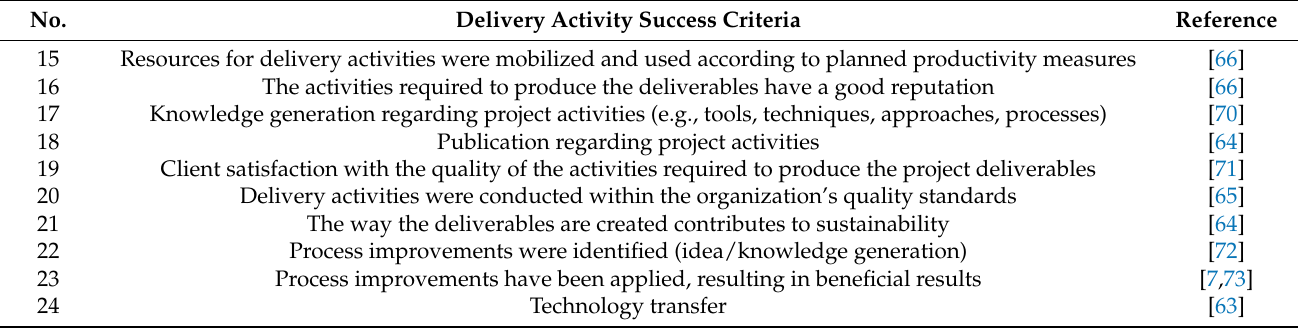
Table 2. Delivery Activity Success